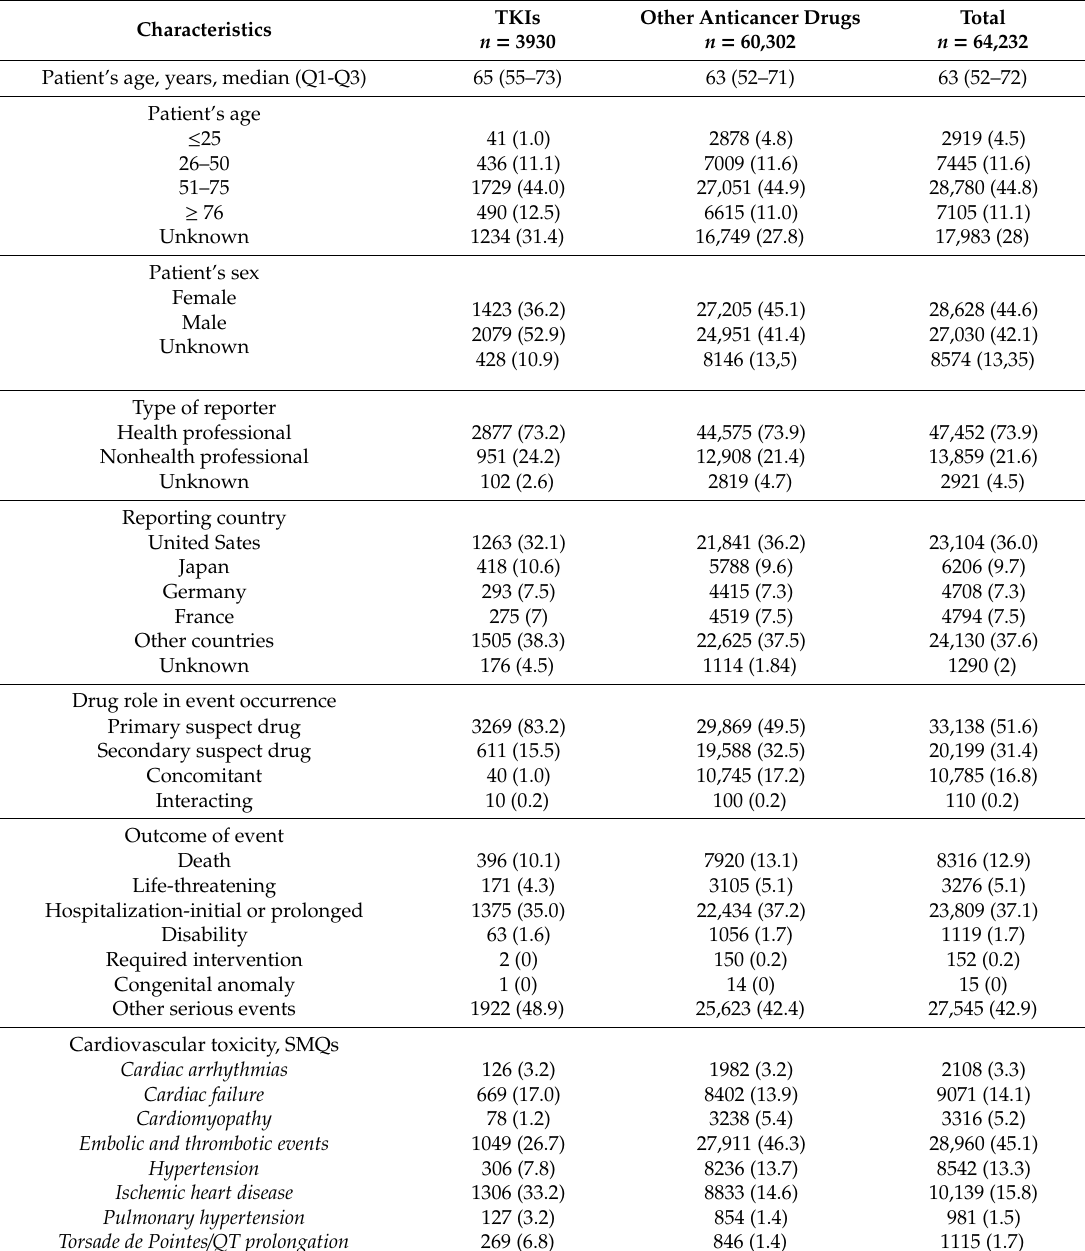
Table 1. Characteristics of cases of cardiovascular